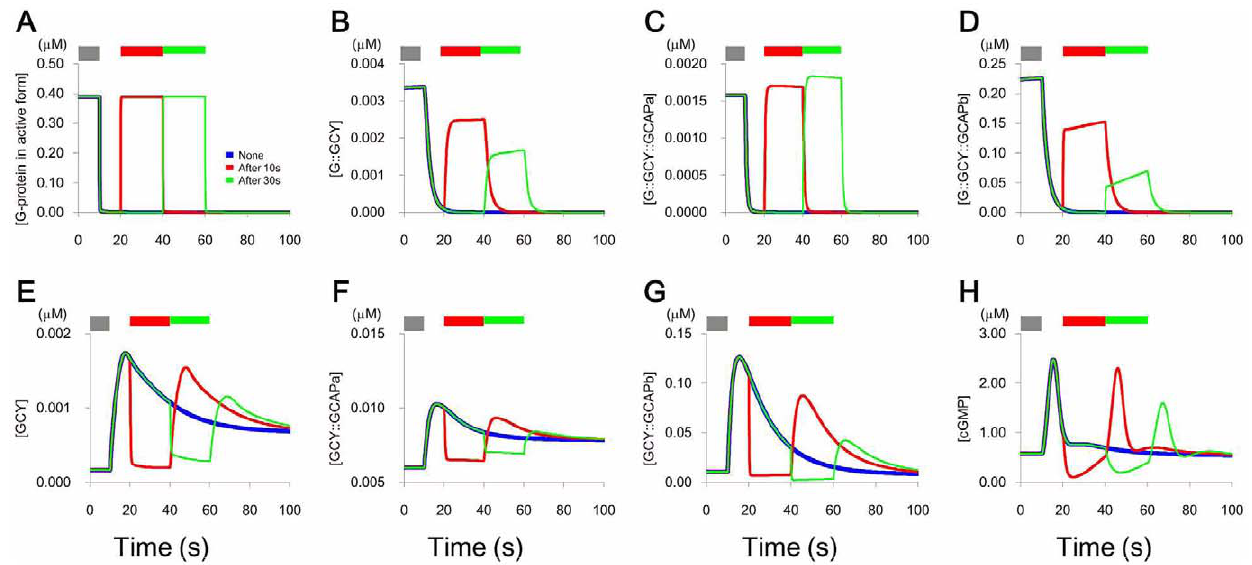
Figure 4. Changes in the components by addition of the second stimulus. Changes in intracellular pathway components, indicated in each panel, by addition of the second stimulus after 10 s (red) and 30 s (green) after removal of the first stimulus for 5 min.